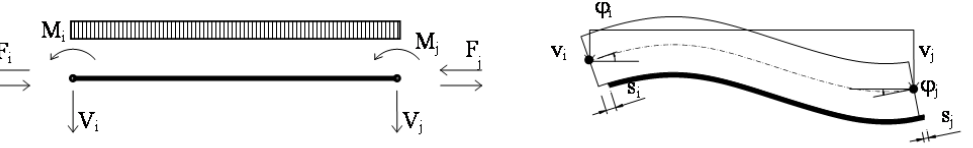
Figure 6 Kinematics and degrees of freedom of the proposed finite element